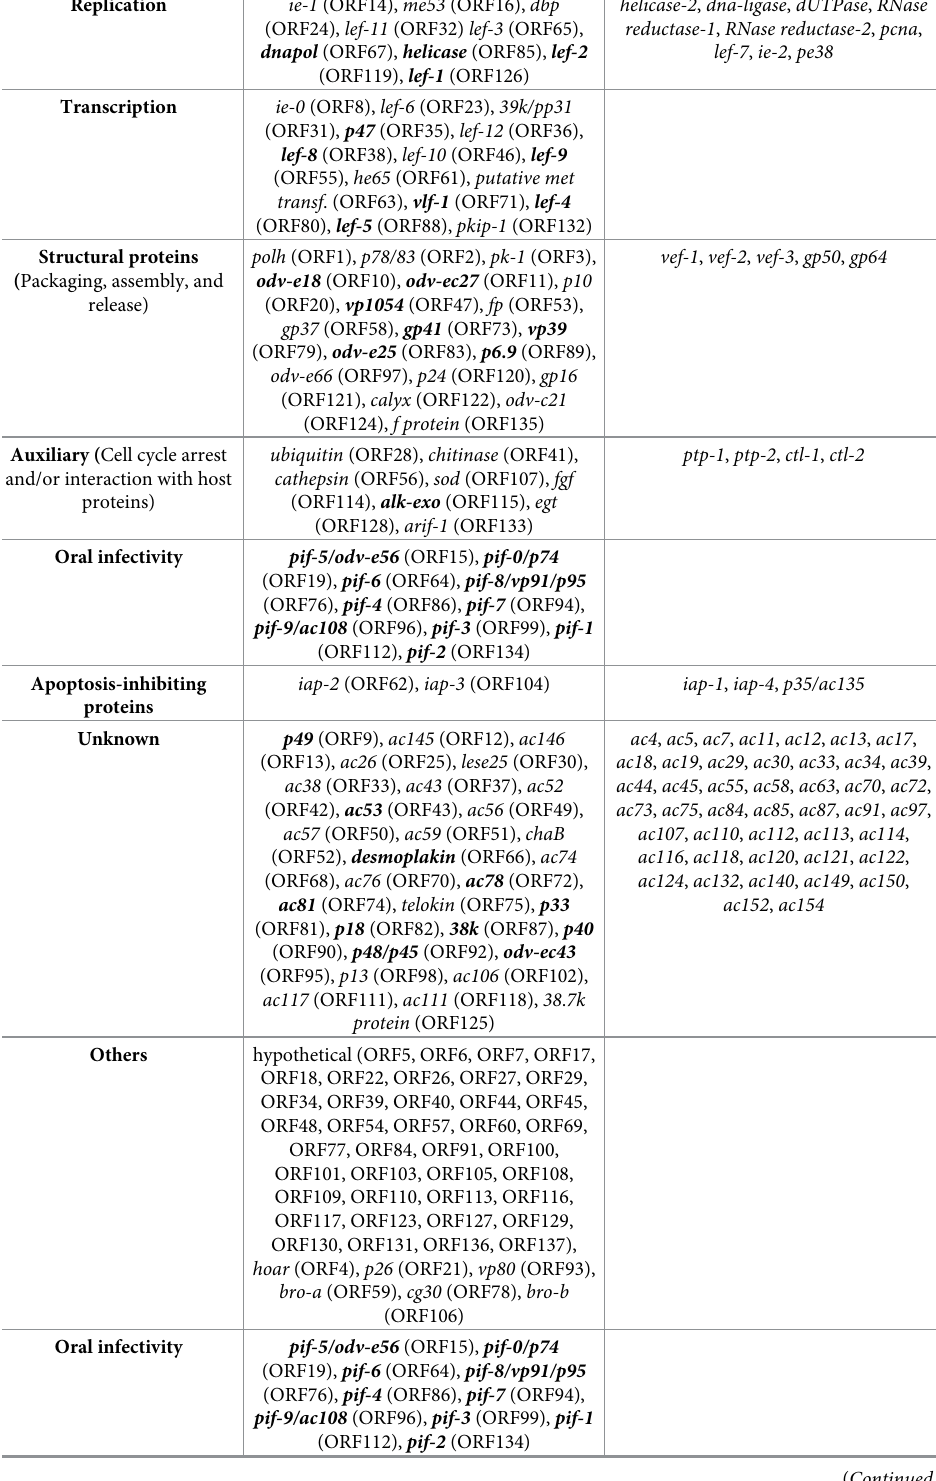
Table 1. Classification of functional genes in HearNPV-TR